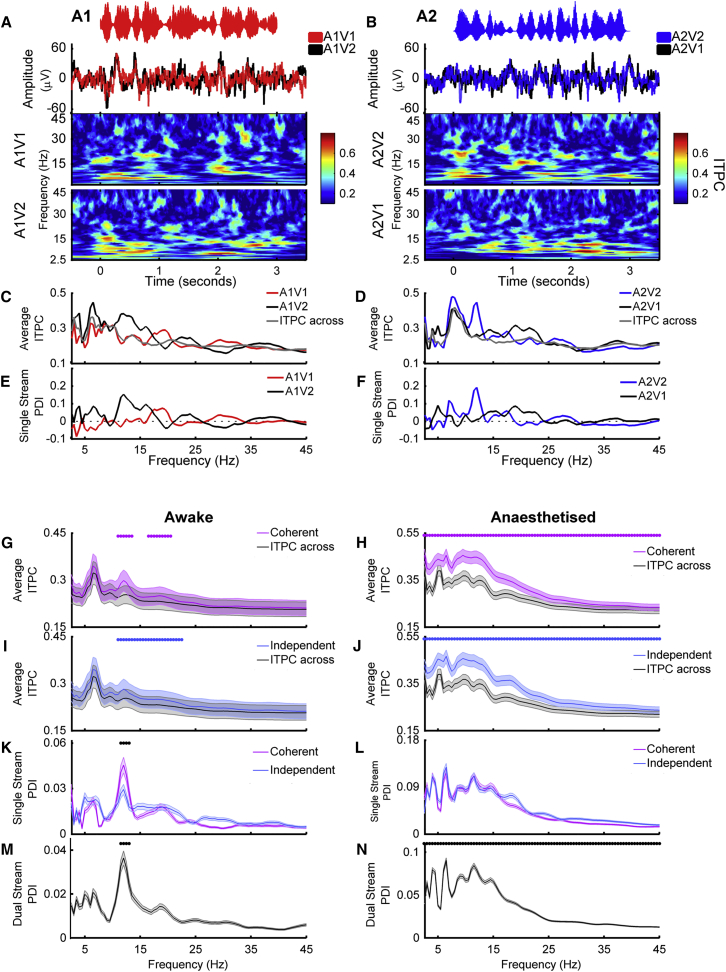
Visual Stimuli Elicit Reliable Changes in the Phase of the LFP(A and B) Example LFP responses to single-stream auditory stimuli (A, A1 stream; B, A2 stream) across visual conditions. Data obtained from the recording site at which multi-unit spiking activity discriminated auditory stream identity in Figures 5A and 5B. The amplitude waveforms of the stimuli are shown in the top row, with the evoked LFP underneath (mean across 21 trials). The resulting inter-trial phase coherence (ITPC) values are shown in the bottom two rows, top row showing temporally coherent auditory-visual stimuli, bottom row showing temporally independent auditory-visual stimuli.(C and D) ITPC averaged across stimulus presentation time was calculated for each stimulus separately (C, A1V1 and A1V2; D, A2V2 and A2V1) and for trials with a randomly selected visual stimulus (ITPC across).(E and F) Single-stream phase dissimilarity values (PDI) were calculated by comparing ITPC within values to the ITPC across null distributions for each stimulus class (E, A1V1 and A1V2; F, A2V2 and A2V1).(G and H) Population mean ITPC values across frequency for temporally coherent stimuli (G, awake dataset, significant frequencies 10.5–13, 16–20 Hz; H, anesthetized dataset).(I and J) Population mean ITPC values across frequency for temporally independent stimuli (I, awake dataset, significant frequencies 10.5–22 Hz; J, anesthetized dataset, no frequencies significantly different). Dots indicate frequencies at which the ITPC-within values were significantly greater than the ITPC-across values (pairwise t test, α = 0.0012, Bonferroni corrected for 43 frequencies).(K and L) Mean (±SEM) single-stream phase dissimilarity index (PDI) values for coherent and independent stimuli in awake animals (K, significant frequencies 10.5–12.5) and anesthetized (L) animals. Black dots indicate frequencies at which the temporally coherent single-stream PDI is significantly greater than in the independent conditions (p < 0.001).(M and N) Mean (±SEM) dual-stream PDI values for awake (M, significant frequencies 10.5–12.5) and anesthetised (N) datasets.